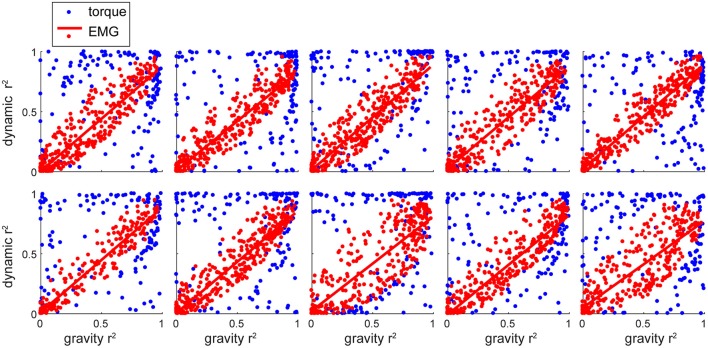
The relative contribution of individual components to EMG and muscle torques per subject. Each plot shows data for a single subject. Each dot represents a value per signal (muscle or DOF) per movement.